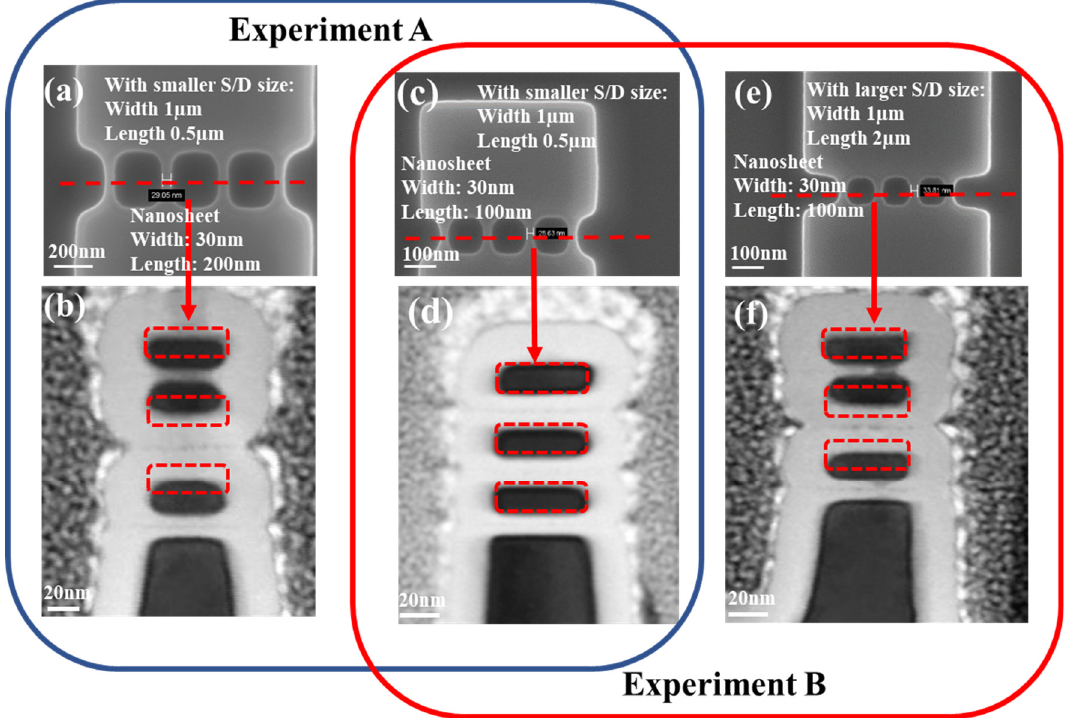
Figure 2. ( a ) Top view SEM image and ( b ) cross-section view TEM image of 3-layer GAA Si nanosheets with length 200 nm and smaller S/D size; ( c ) Top view SEM image and ( d ) cross-section view TEM image of 3-layer GAA Si nanosheets with length 100 nm and smaller S/D size. ( e ) Top view SEM image and ( f ) cross-section view TEM image of 3-layer GAA Si nanosheets with length 100 nm and larger S/D size.